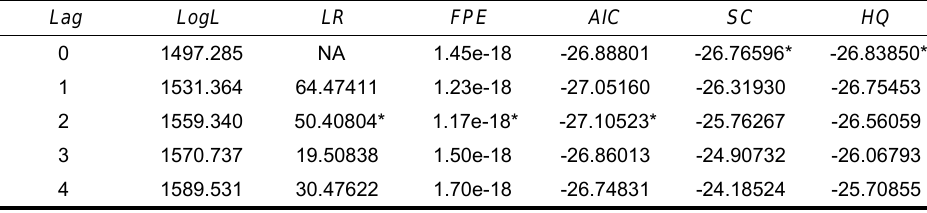
Table 3. Lag selection criteria of the VAR model